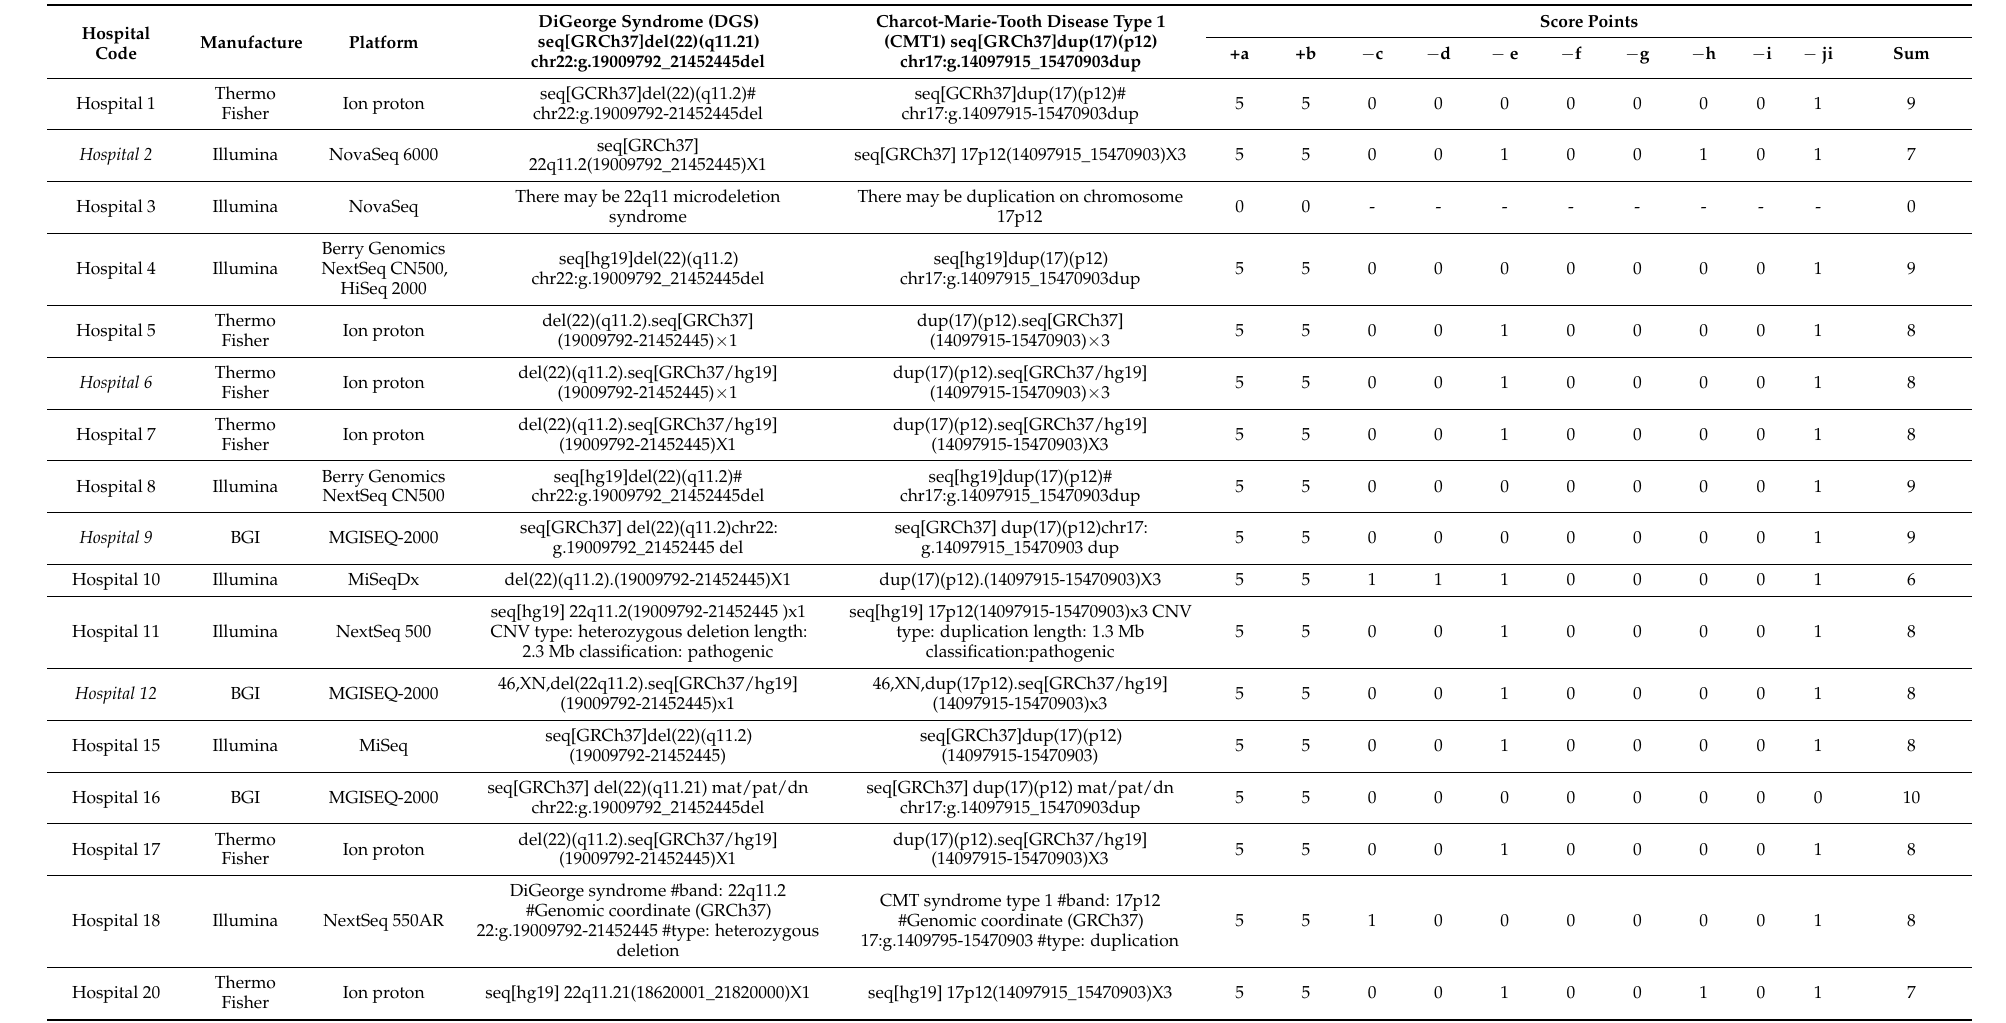
Table 3. Overview of variant nomenclatures submitted by participating